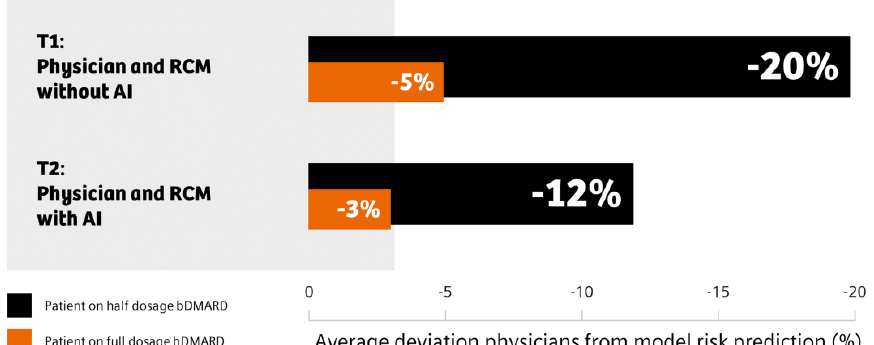
Figure 5. Deviation of flare risk predicted by physicians compared to the flare risk prediction tool. Mean flare risk deviations in percent between physicians and the AI-powered flare risk prediction tool at T1 (physicians had no access to the flare prediction tool, upper bar graphs) and at T2 (physi- cians had access to the flare prediction tool, lower bar graphs) are shown. Black represents the flare risk prediction deviation for the patient on a half dosage of bDMARD and orange indicates that for the patient on a full dosage of bDMARD. patient on a full dosage of bDMARD.